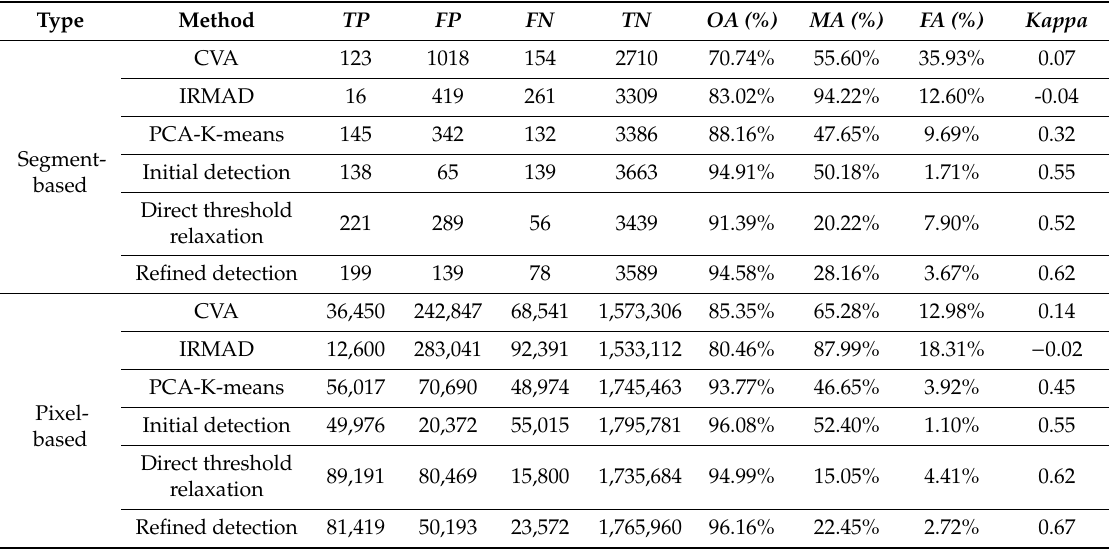
Table 4. Detection precision in area